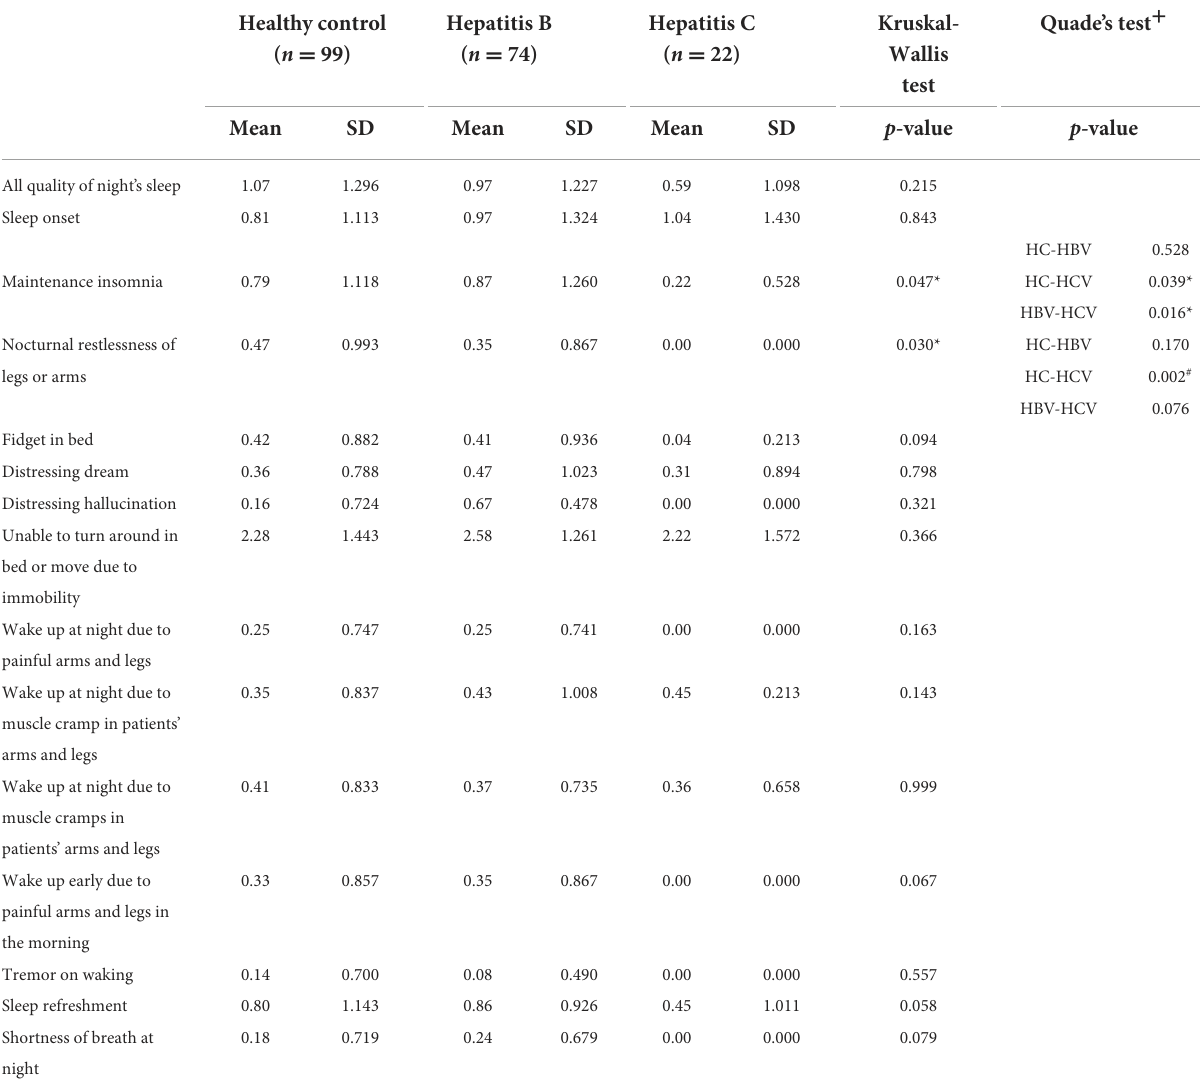
TABLE 4 The evaluation of sleep disturbance profiles with PDSS2 between different study groups.